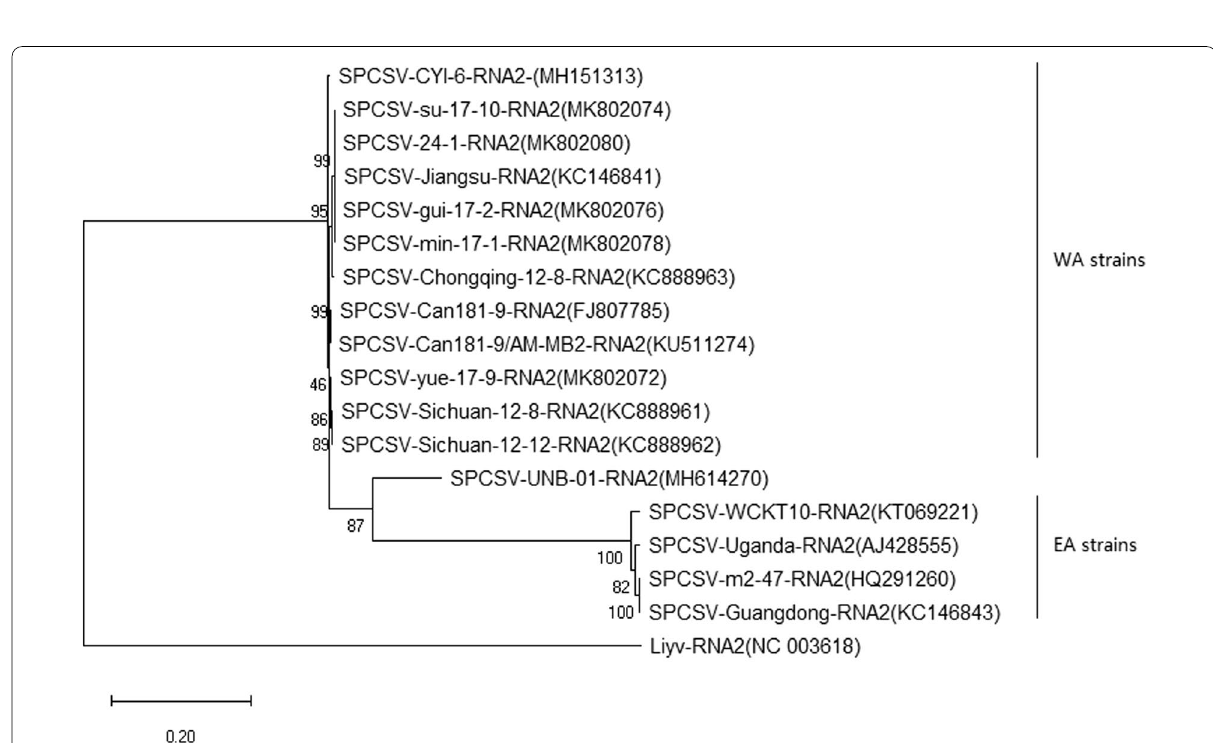
Fig. 4 Phylogenetic tree of RNA2 segments of SPCSV isolates. The tree was generated using MEGA X (the Maximum Likelihood method, General Time Reversible model and 1000 bootstrap replicates). Liyv RNA2 segment (NC_003618) was used as an